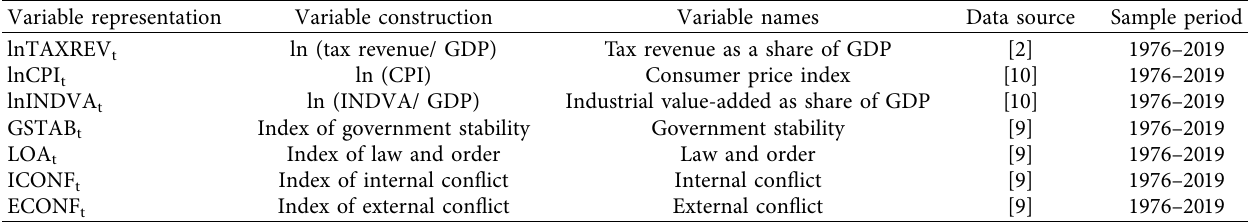
Table 1: Variable and data